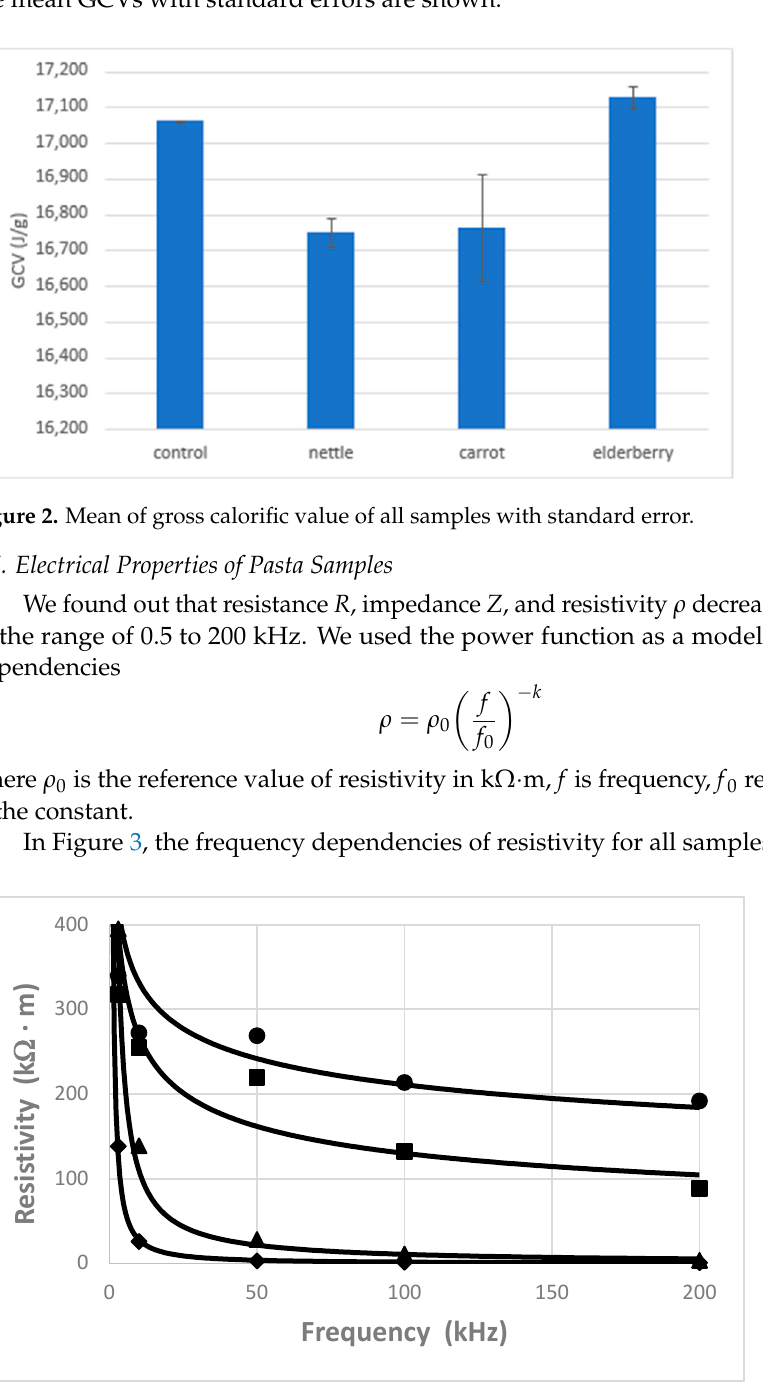
Figure 3. Frequency dependencies of resistivity for value-added pasta samples: ● , control; ■ , with nettle; ▲ , with carrot; ♦ , with elderberry.